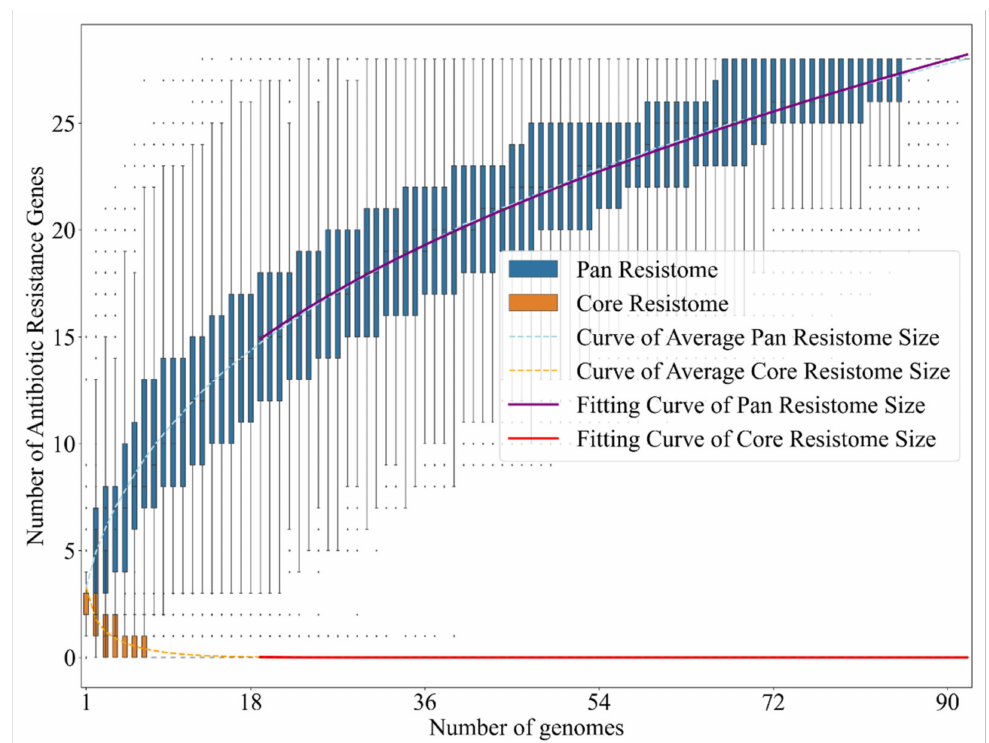
Figure 6. Development of the pan-resistome of Vibrio cholerae . Used the power law and combinatorial analysis to predict the addition of new ARGs per genome in the species. The purple line comprises the fitted curve of the pan-resistome appropriate for its development, while the bars in blue represent the addition of new ARGs. The same for the core-resistome in